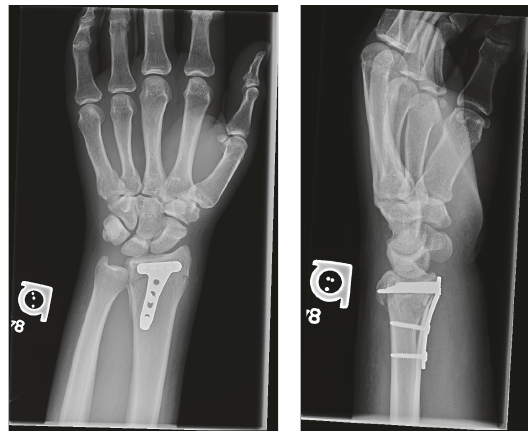
Figure 6: Anteroposterior and lateral X-rays of the affected wrist at the 6-week